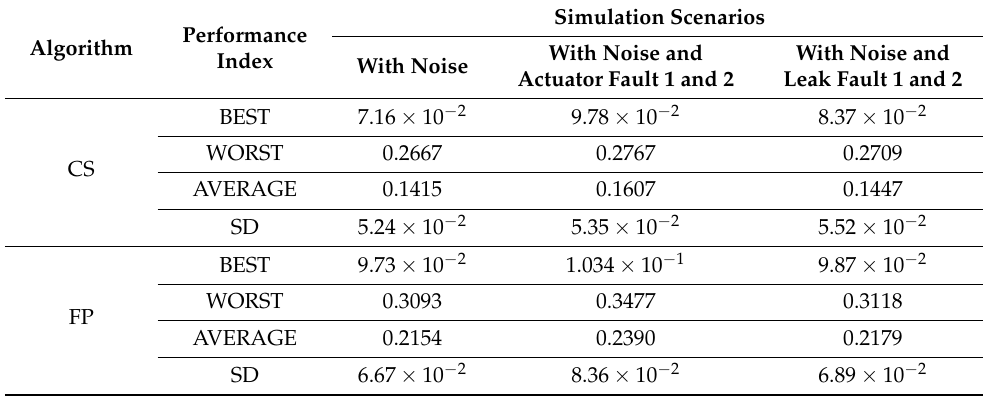
Table 6. Results of metrics of Mean Square Error (MSE) values to found by fuzzy CS and fuzzy FP algorithm using ST2FIS.